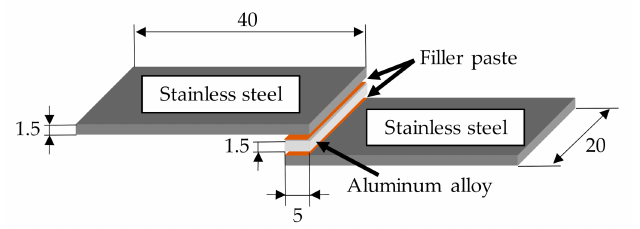
Figure 1. Investigated material combination, produced using a filler paste (mm)